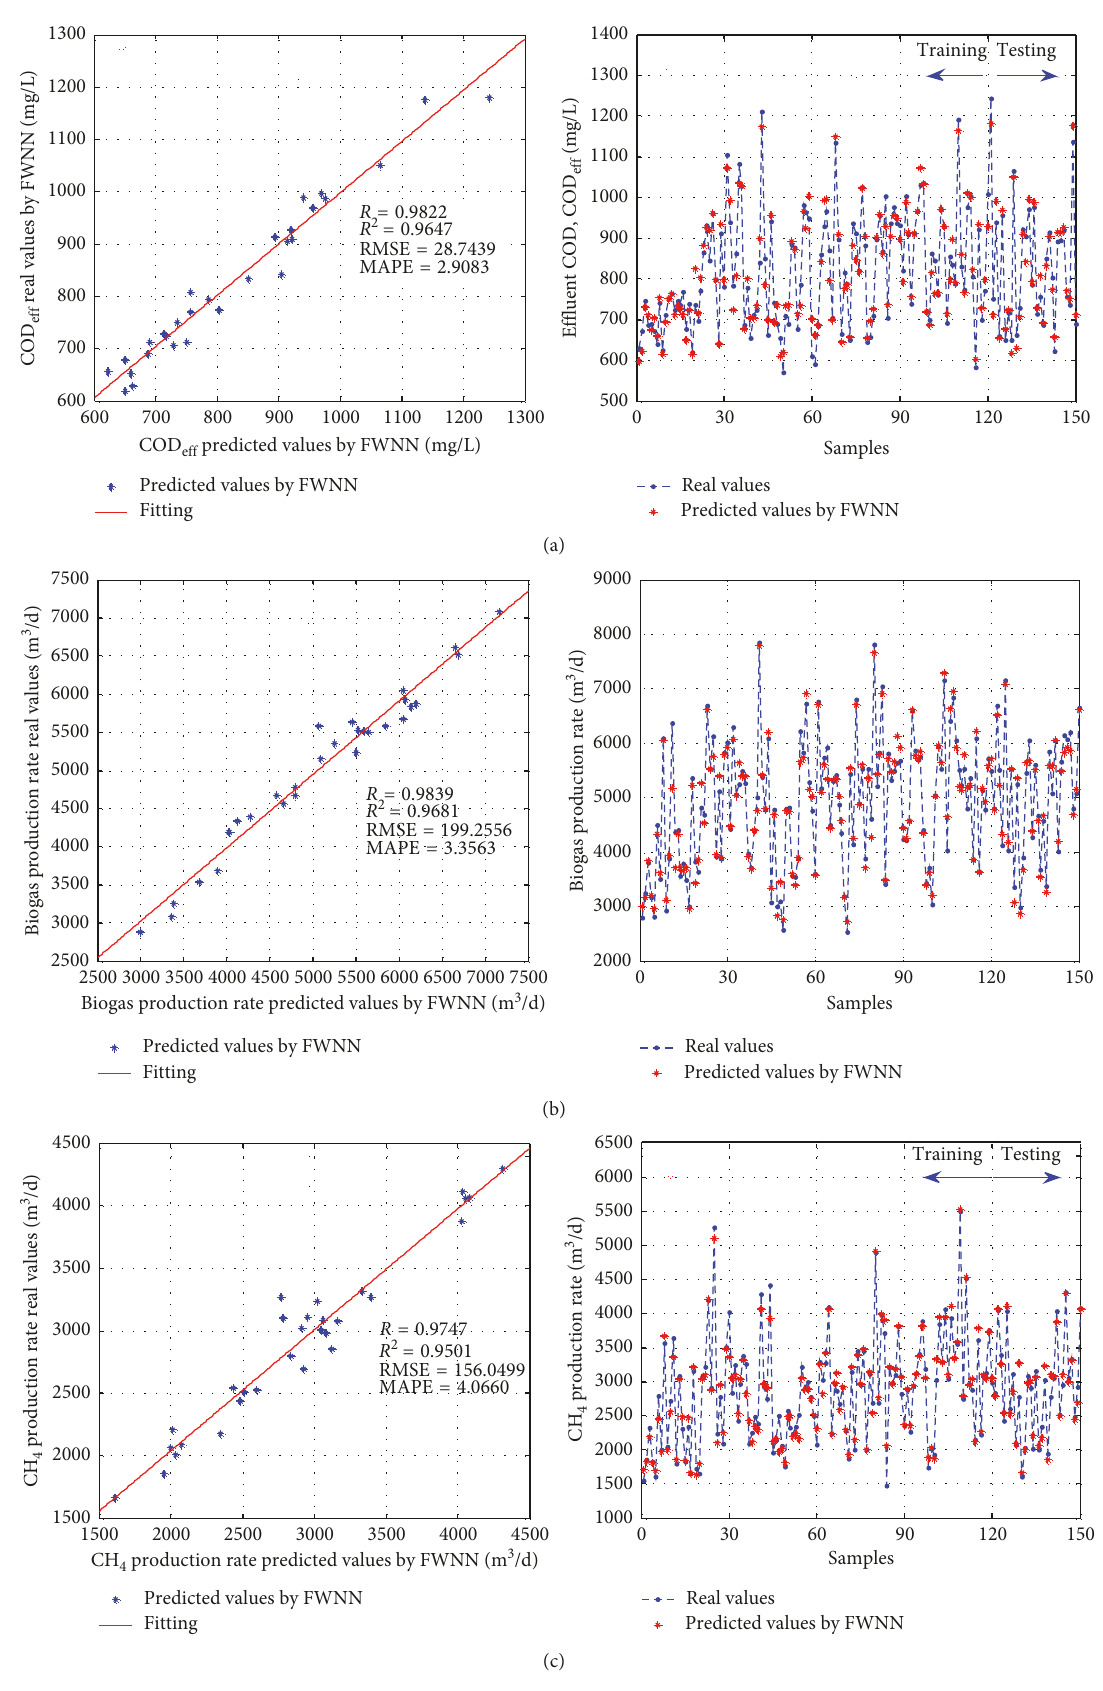
Figure 4: FWNN performance of the estimation of effluent concentrations and biogas (methane) production